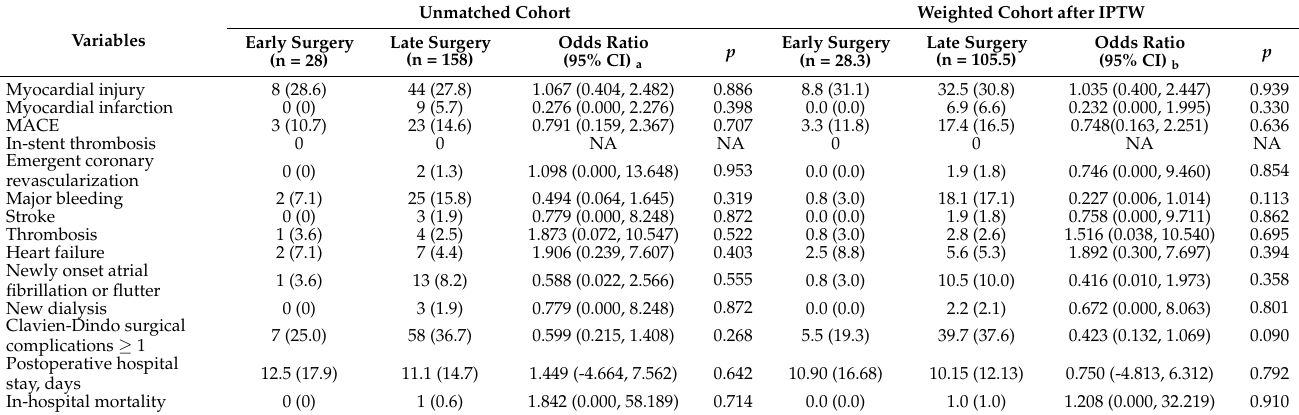
Table 2. Myocardial injury and other complications between early and late surgery before and after